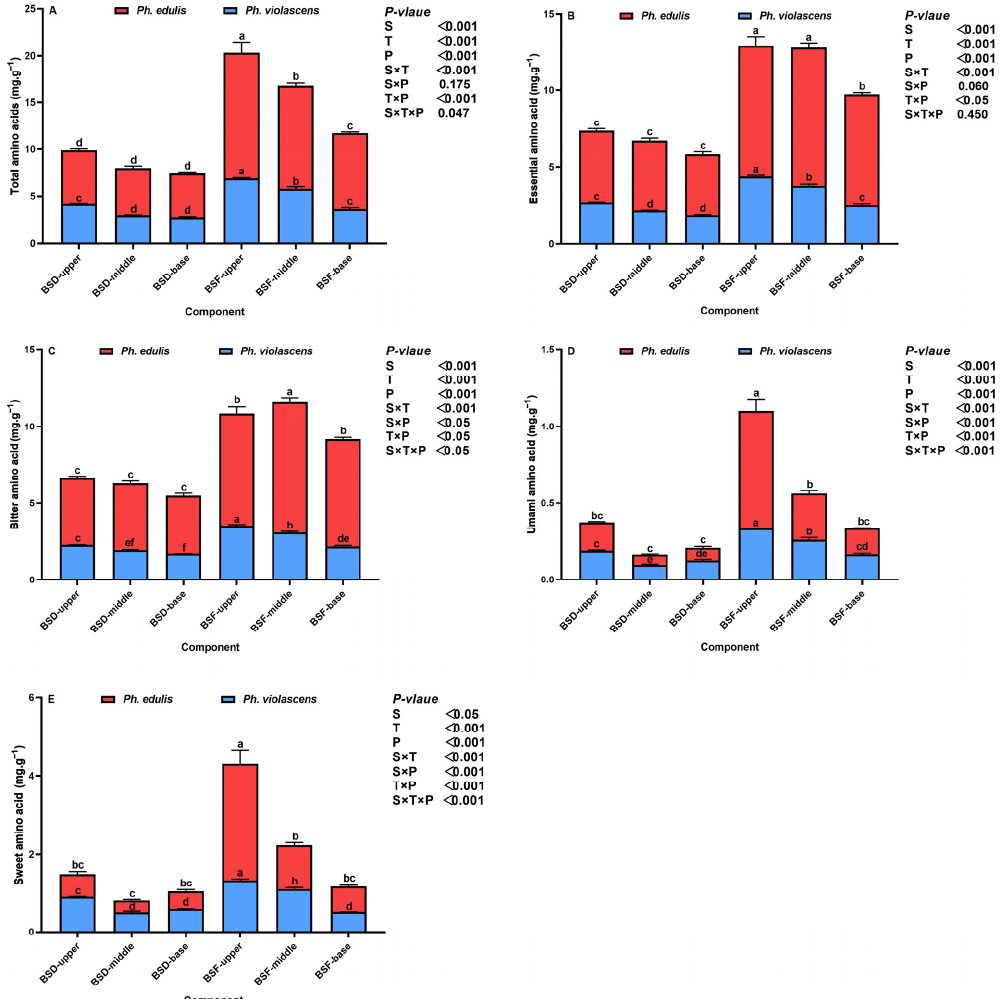
Figure 4. Changes in the amino acid composition of bamboo shoot diaphragm (BSD) and flesh (BSF) of Ph. edulis and Ph. violascens . ( A ) Total amino acid, ( B ) essential amino acid, ( C ) bitter amino acid, ( D ) umami amino acid, and ( E ) sweet amino acid flavor compounds. BSD and BSF refer to bamboo shoot diaphragm and flesh, respectively. Vertical bars are means ± SD of the four replicates. Different lowercase letters above the bars in each graph represent significant differences at p < 0.05 between the different bamboo shoot components. p values are only shown for the main and interactive effects of species (S), components (C), and positions (P), respectively, of each